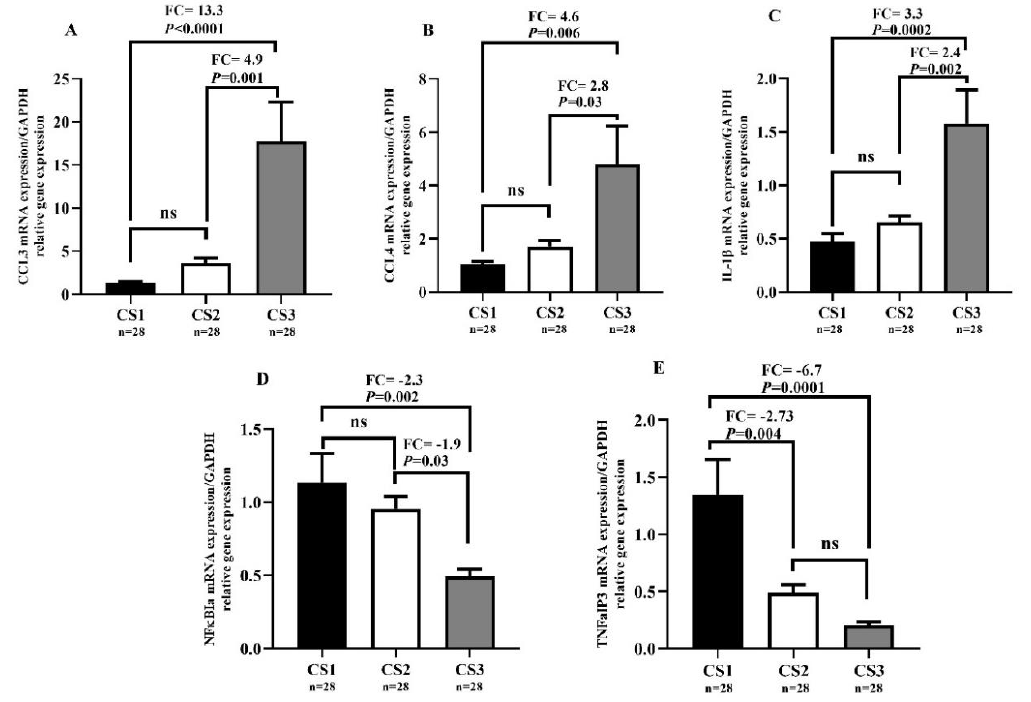
Figure 2: Relative expression levels of CCL3 , CCL4 , IL-1β , TNFαIP3 , and NF-κBIα genes of the participants and their relation with the number of clogged arteries. P -values ≤0.05 were considered as significant using one-way ANOVA test and Tukey post hoc test multiple comparison analysis. Results are expressed as mean ±